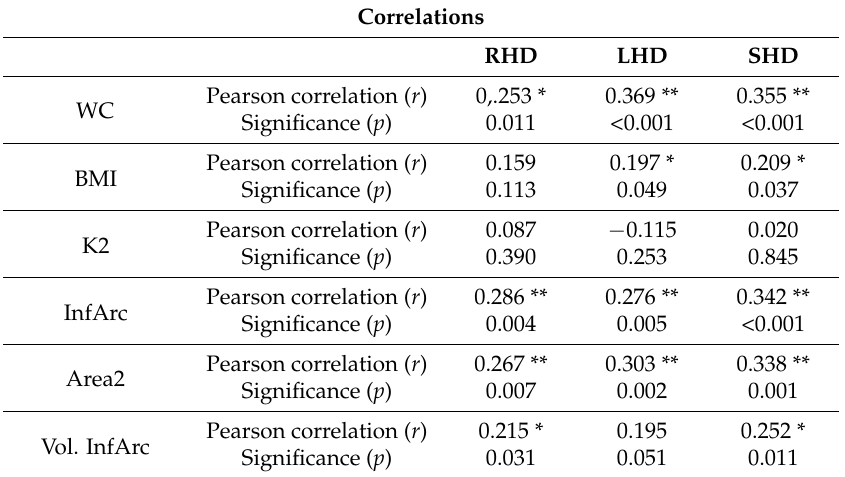
Table 2. Statistical correlations between liver diameters and most significant measurements. Correlations